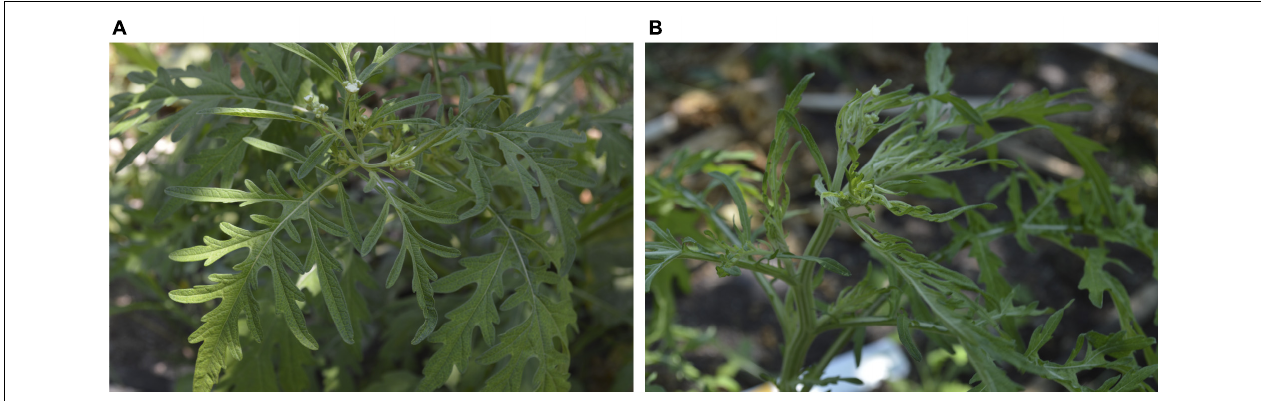
FIGURE 1 | Galium mexicanum plants sampled in Tecomán, Colima, México. (A) Plant with a symptomless appearance. (B) Plants exhibiting apical leaf distortion symptoms.